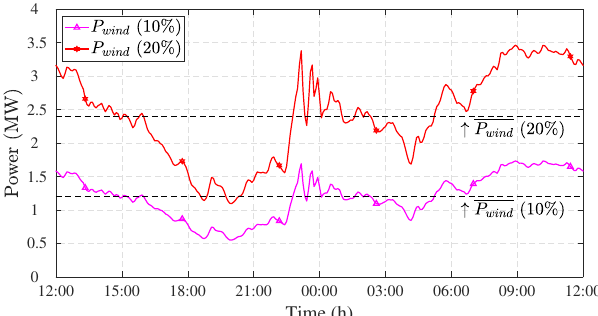
Figure 12. Net wind power profile of all wind distributed generations (WDGs) in the feeder for 10% and 20% RE